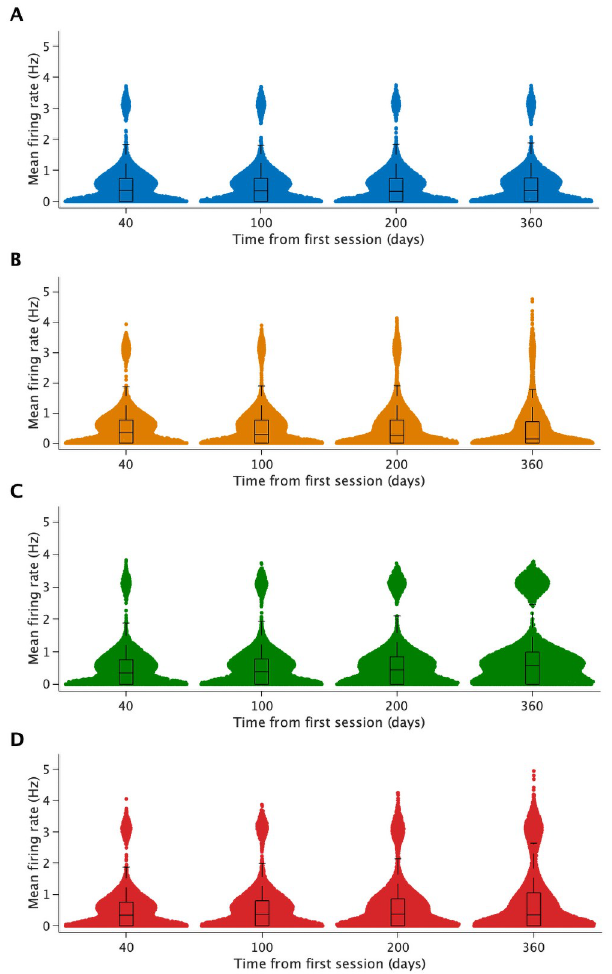
Fig 3. Each model exhibits characteristic changes in firing rate. Swarm plots showing mean firing rates of CA1 pyramidal cells from day 40 to day 360 in the wildtype (A), the grid-to-pyramidal-cell synapse loss model (B), the interneuron-to-pyramidal-cell synapse loss model (C) and the double synapse loss model (D). Boxplots show median and interquartile range. The results of a single run of each simulation are shown. Histograms of the same data are shown in S2